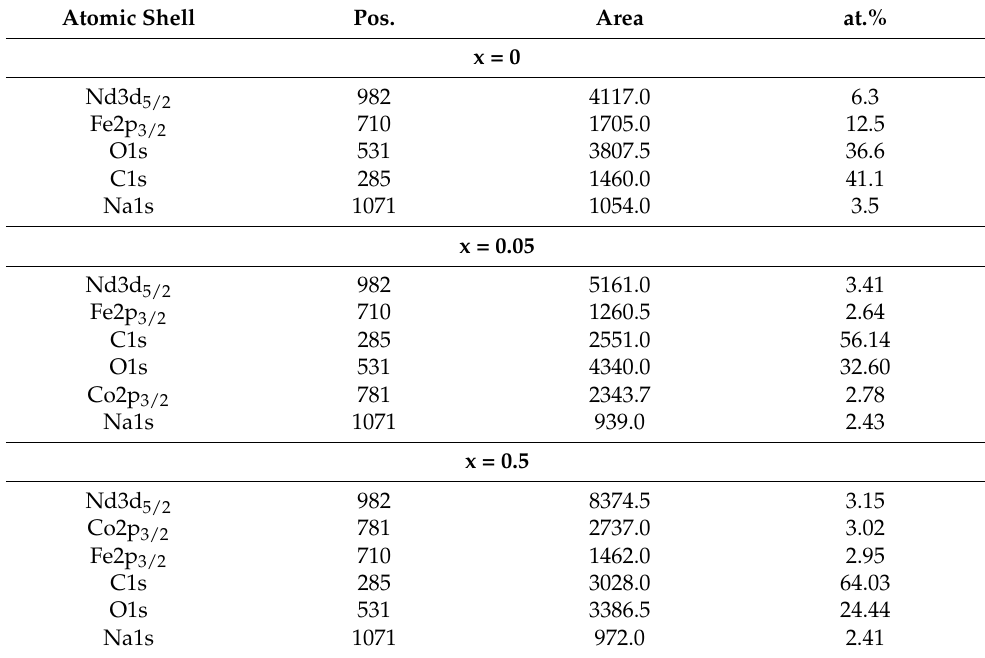
Table 3. Concentrations of identified atoms from the NdFe (1 − x) Co x B oxide samples.